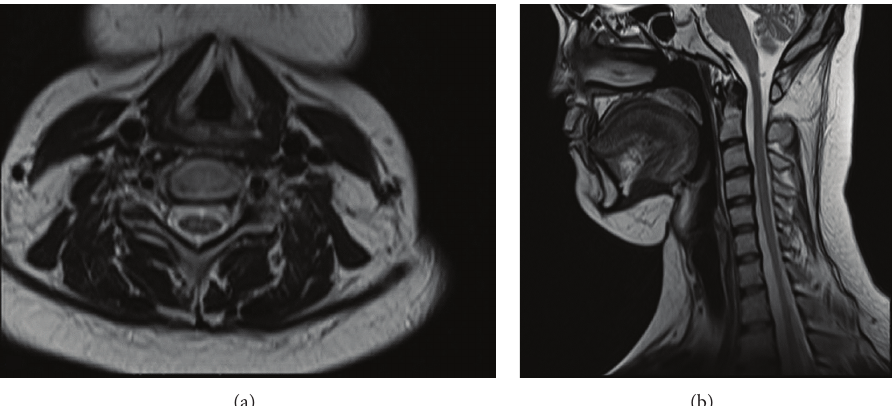
Figure 2: Posttreatment T2-weighted axial (a) and sagittal (b) MR images show normal signal intensity of cervical spinal cord.